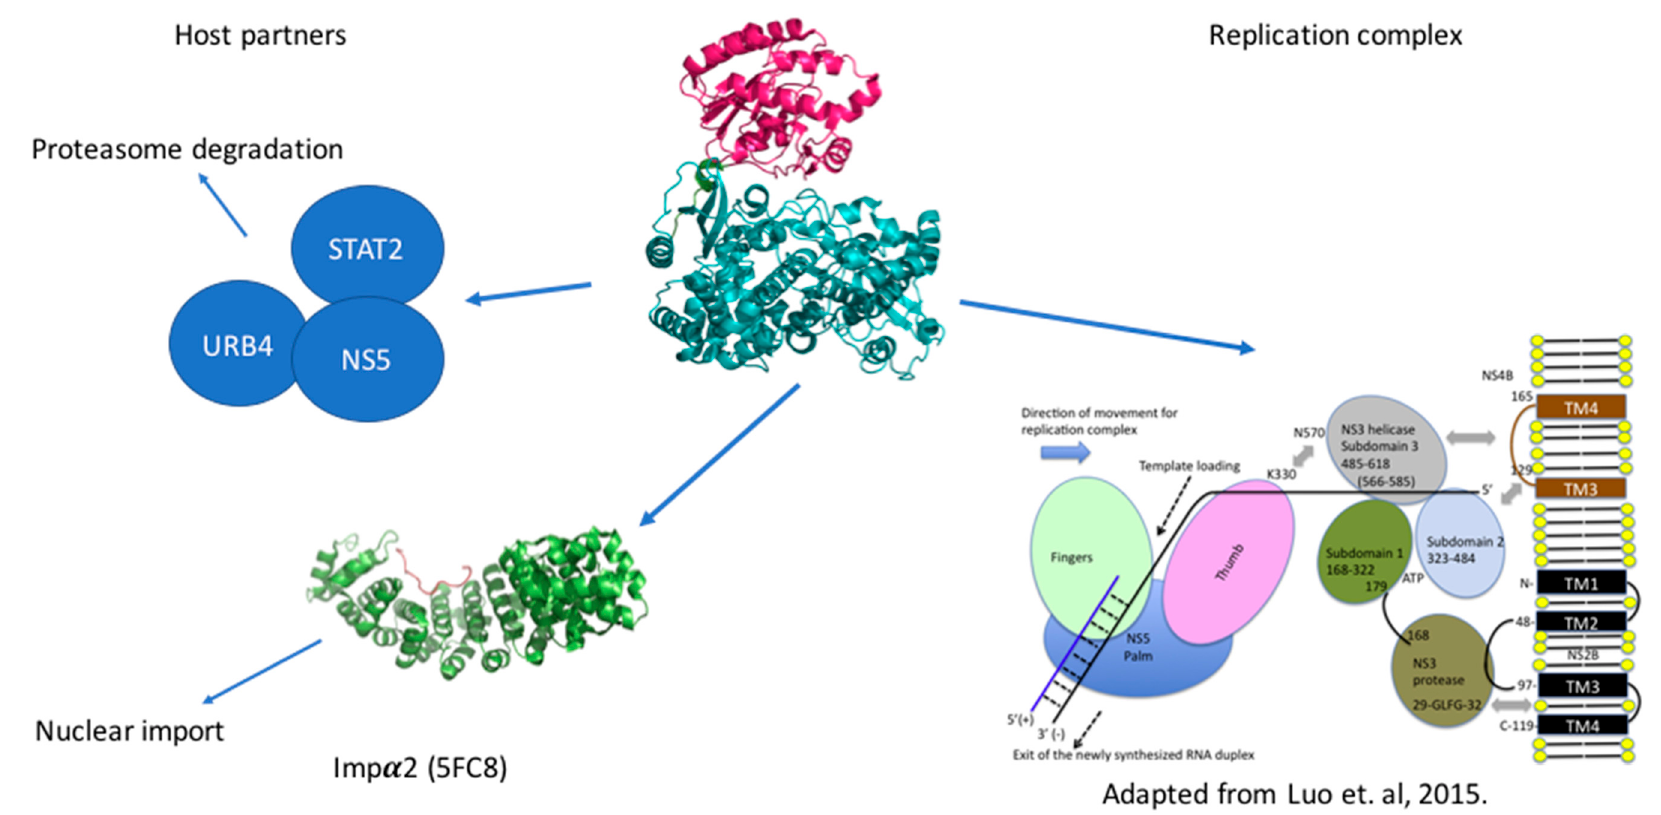
Figure 4. DENV NS5 interactome. Schematic view of the interactions established by NS5 in the infected cells. In the endoplasmic reticulum (ER) vesicles NS5 interacts with NS3 to replicate and cap the genomic RNA. NS5 brings the STAT2 protein and the URB4 close and triggers the degradation of the formed complex. The C-terminal region is recognized by the Imp α 2 protein for the import of NS5 protein into the nucleus.